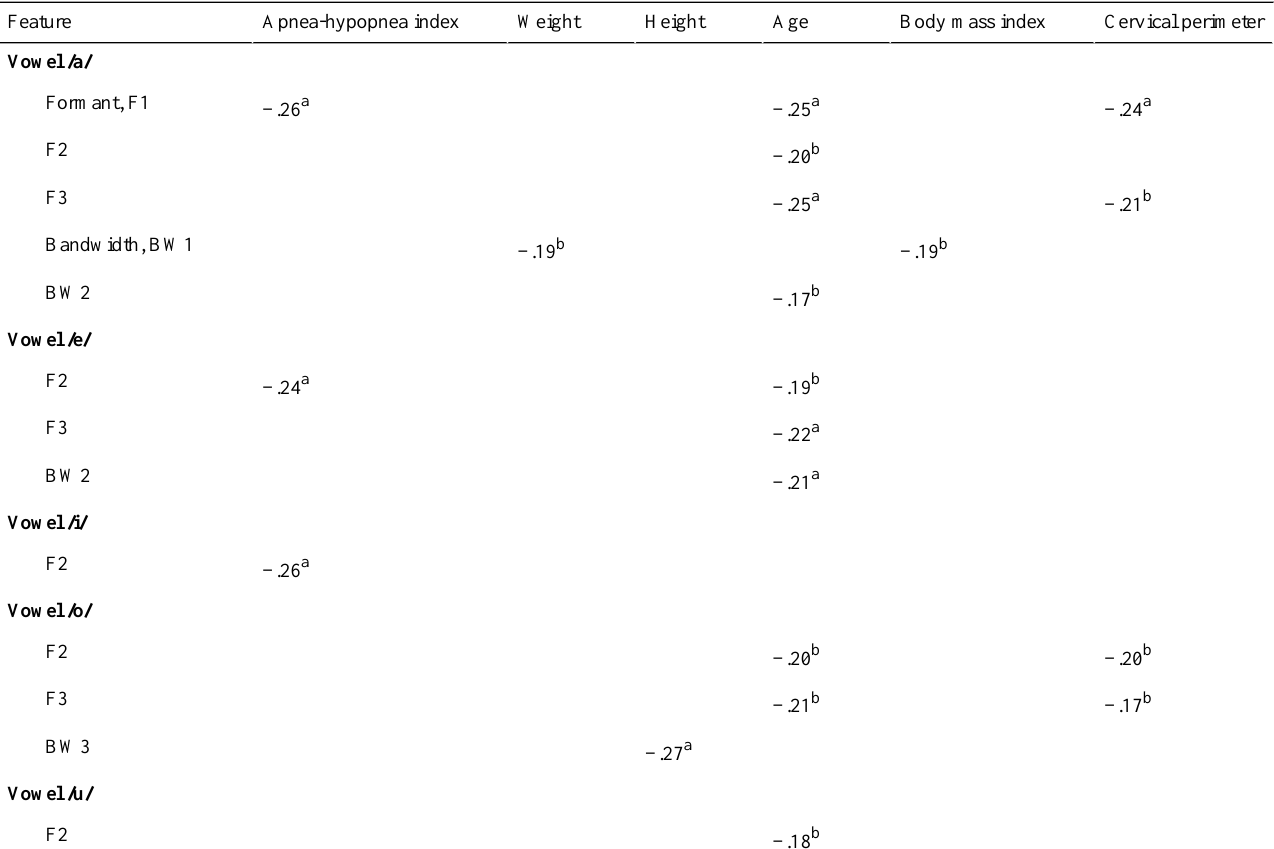
Table 4. Statistically significant Spearman correlation between formant frequencies, bandwidths, and clinical variables on the female (n=129) population (for clarity, nonsignificant correlation values are